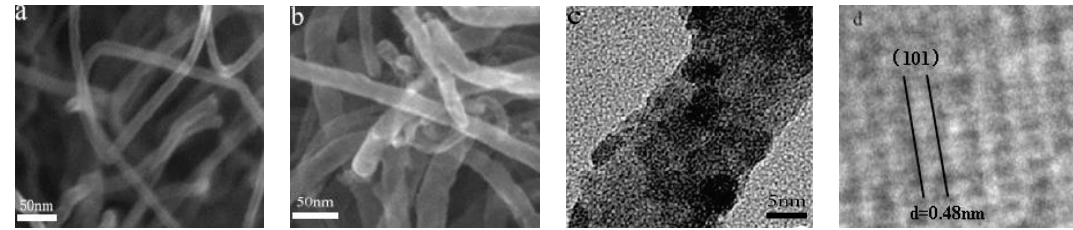
Figure 2. SEM image of ( a ) purified CNTs ( b ) Mn 3 O 4 /CNTs-3 composites; ( c ) TEM image of Mn 3 O 4 /CNTs-3; ( d ) HRTEM image of the Mn 3 O 4 supported on CNTs.